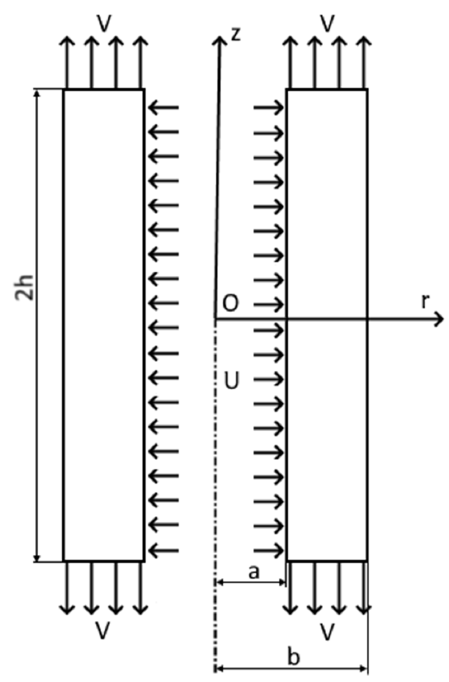
Figure 1. A schematic diagram of the boundary value problem.